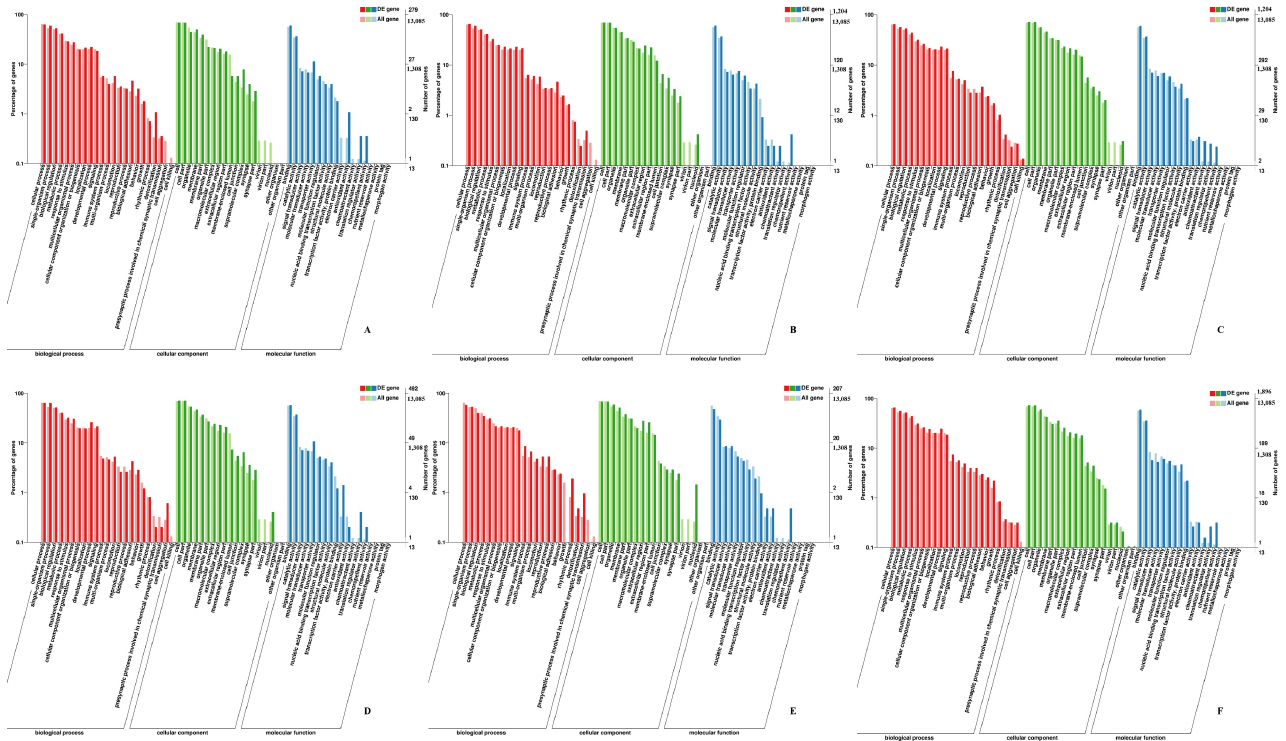
Figure 5. GO enrichment analysis of DEGs in Pekin duck. ( A ) PE17B_vs_PE21B; ( B ) PE21B_vs_PE27B; ( C ) PE27B_vs_PM6B; ( D ) PE17L_vs_PE21L; ( E ) PE21L_vs_PE27L; ( F ) PE27L_vs_PM6L. Note: The abscissa were GO terms, the ordinate on the left was percentage of genes in all genes annotated with GO, on the right was the number of